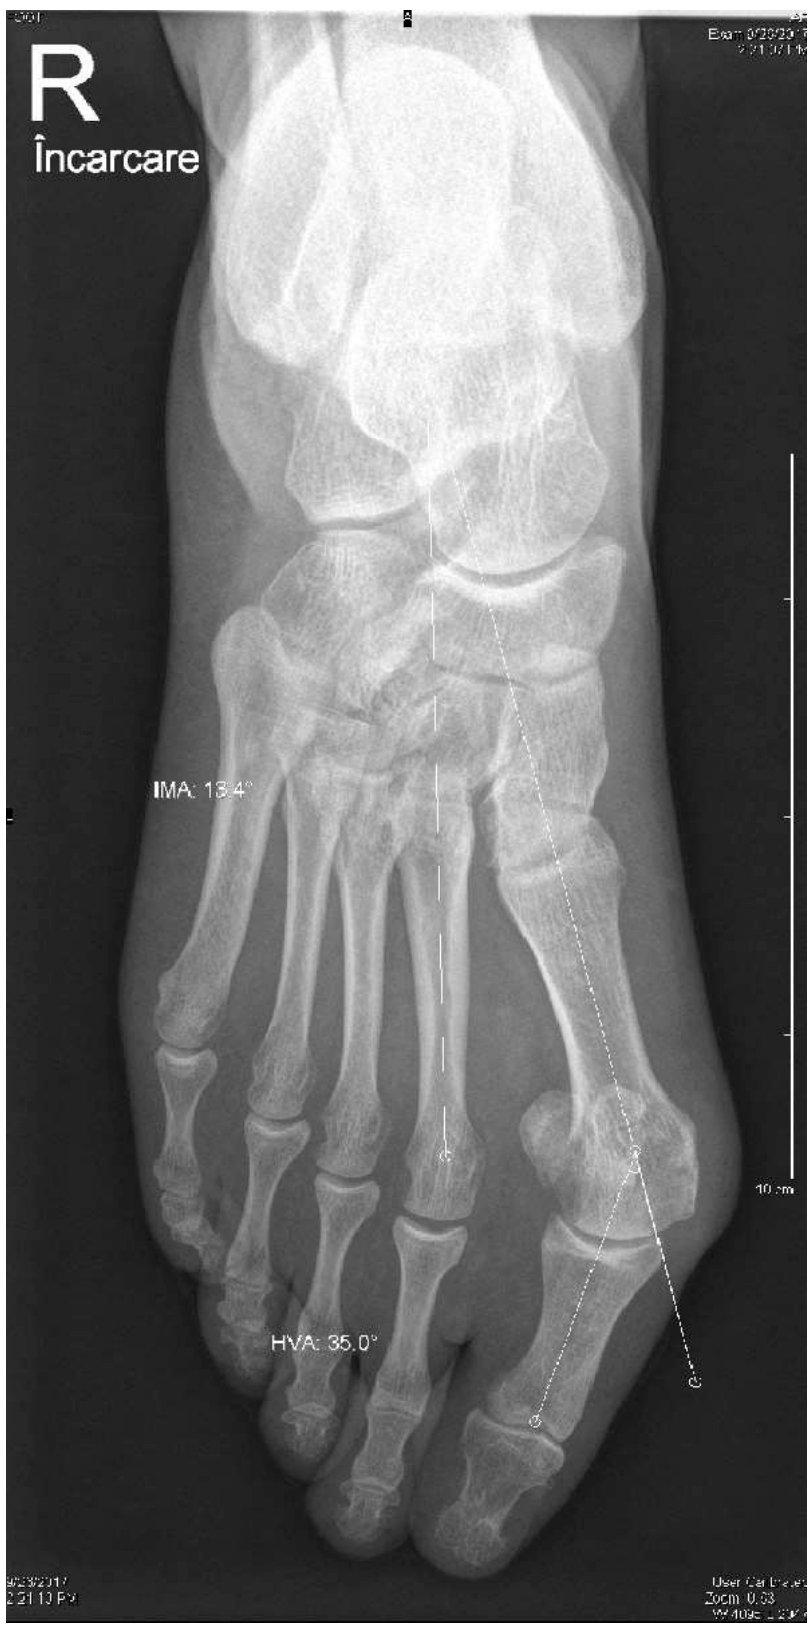
Figure 1. Preoperative weight-bearing anteroposterior image and measurements of HVA and